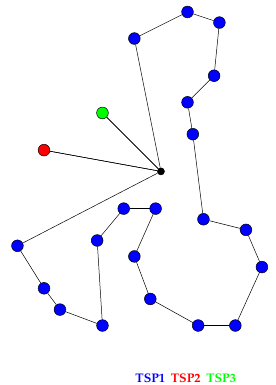
Figure 2. Unbalanced work in the mTSP.